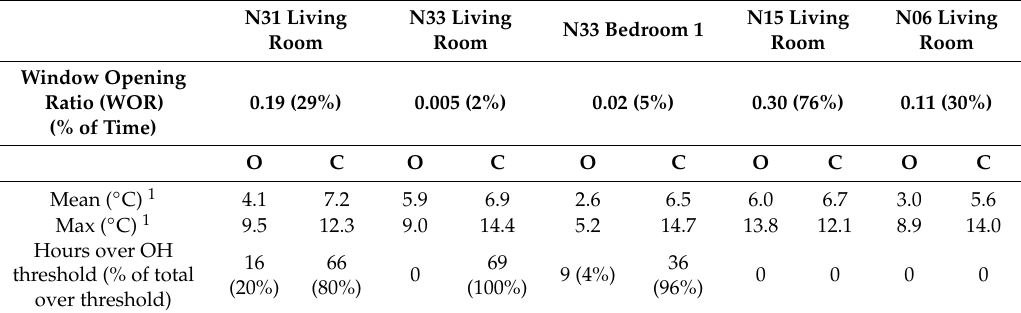
Table 9. Di ff erence in interior and exterior temperature data from window opening (O = open, C =